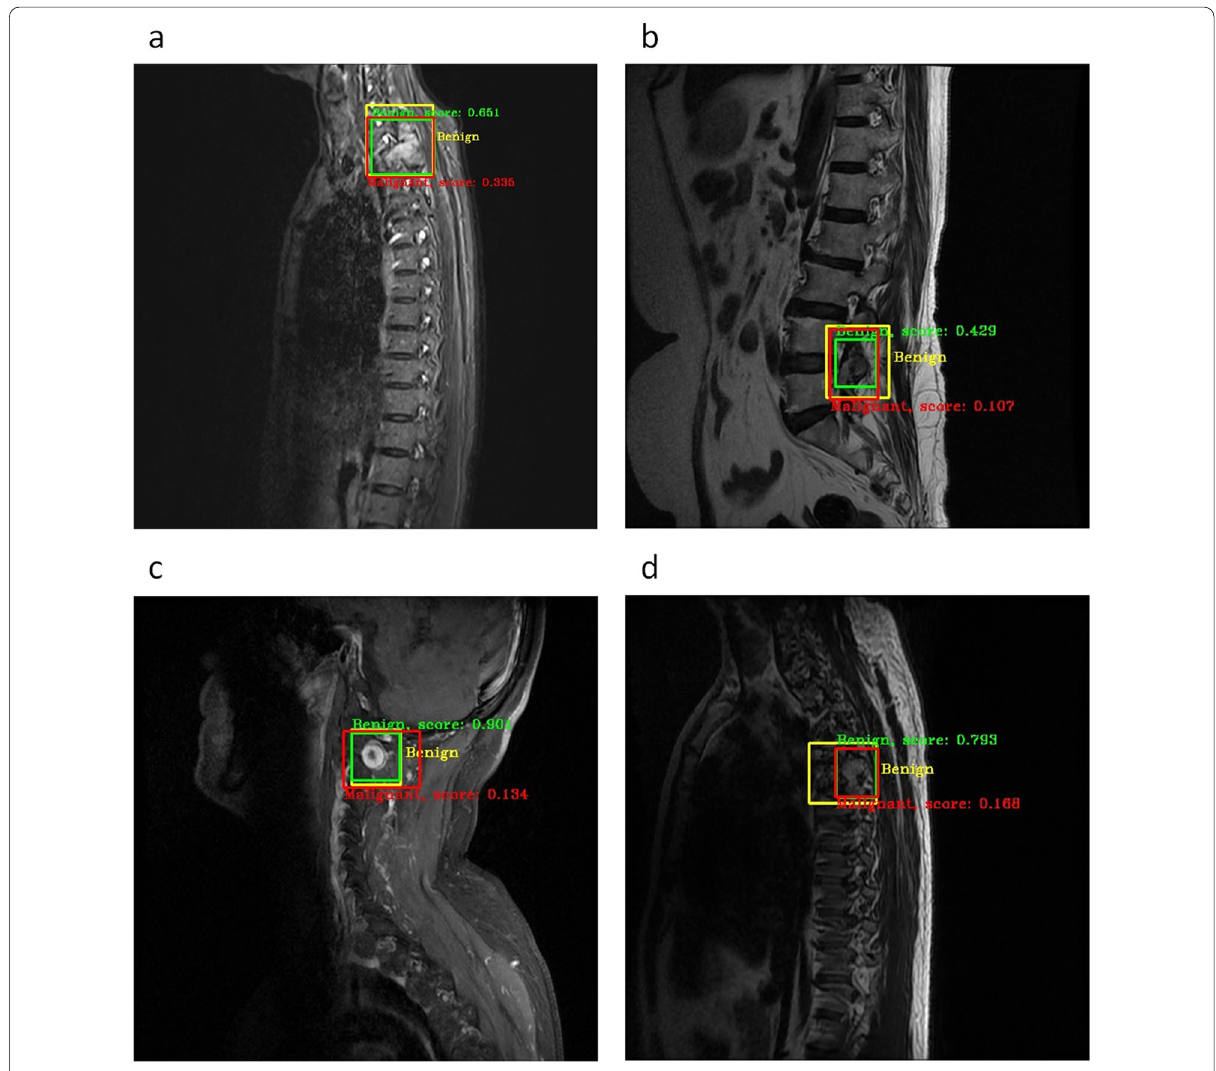
Fig. 4 Tumor regions detected and rough classification